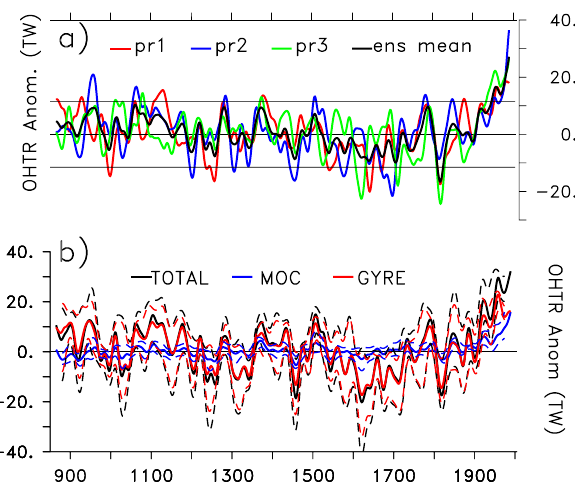
Figure 3. (a) Simulated ocean heat transport (OHTR) to the Arctic (combined OHTR through Fram Strait and Barents Sea Opening) as anomalies w.r.t. the pre-industrial mean; coloured lines indicate individual simulations pr1, pr2 and pr3, and the solid black line is the ensemble mean; thin horizontal lines bracketing the zero line indicate the respective 2 σ ranges derived from the 1000-year-long PiCtrl experiment. (b) Total OHTR (black lines, TOHTR) averaged over 60–65 ◦ N, subdivided into gyre-related OHTR (red, GOHTR), and overturning-circulation-related OHTR (blue, MOHTR). Thick lines represent the ensemble means, and the dashed lines the respec- tive ensemble ranges. All time series were smoothed by a 31-year running mean. Units are TW (1TW = 10 12